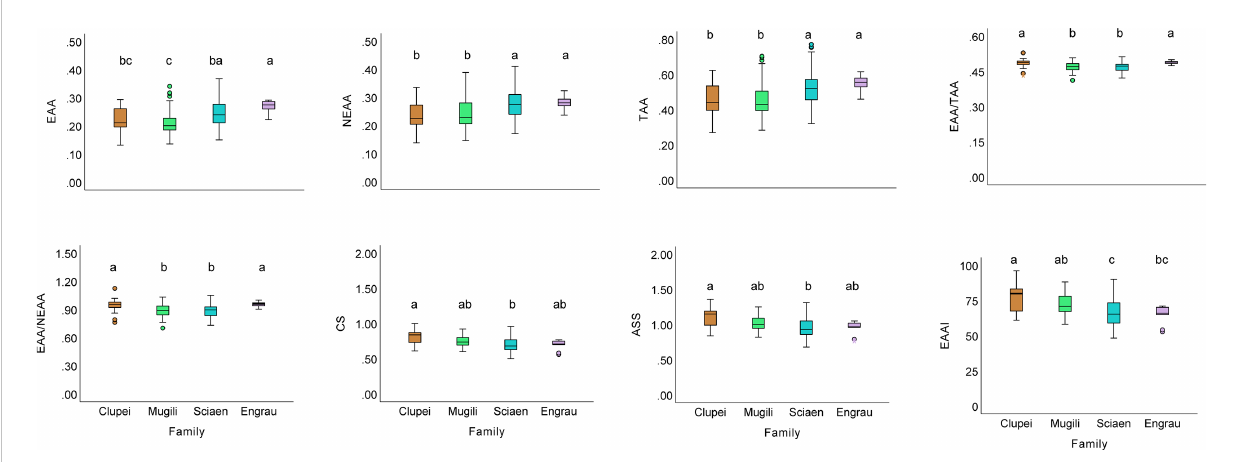
FIGURE 5 The box plots of amino acids composition of fi shes of different families. Different lower-case letters indicate a signi fi cant difference among